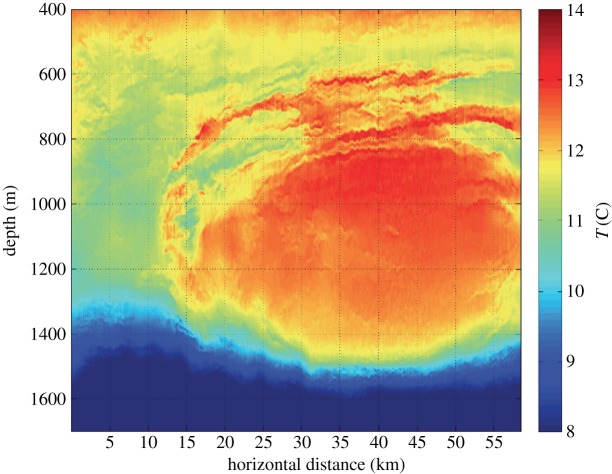
Acoustic image of a temperature cross-section in a Meddy SCV (i.e. SMC eddy of Mediterranean origin) after detachment from the Iberian abyssal boundary current [21]. The SCV is approximately axisymmetric around a central vertical axis. The warm temperature anomaly is accompanied by a positive salinity anomaly such that the vortex centre is neutrally buoyant with a local minimum in |∂zρ|. The T/S anomaly implicates an SCV origin in the subsurface outflow of dense Mediterranean water into the Atlantic, where it descends as an entraining gravity current to a level of neutral buoyancy and flows poleward along isobaths. The encircling anticyclonic circulation is in gradient-wind, hydrostatic momentum-balance with the buoyancy field. The maximum azimuthal velocity is at z≈−1100 m. Meddies are agents in the lateral spreading of the T/S water mass throughout the subtropical Atlantic [22].